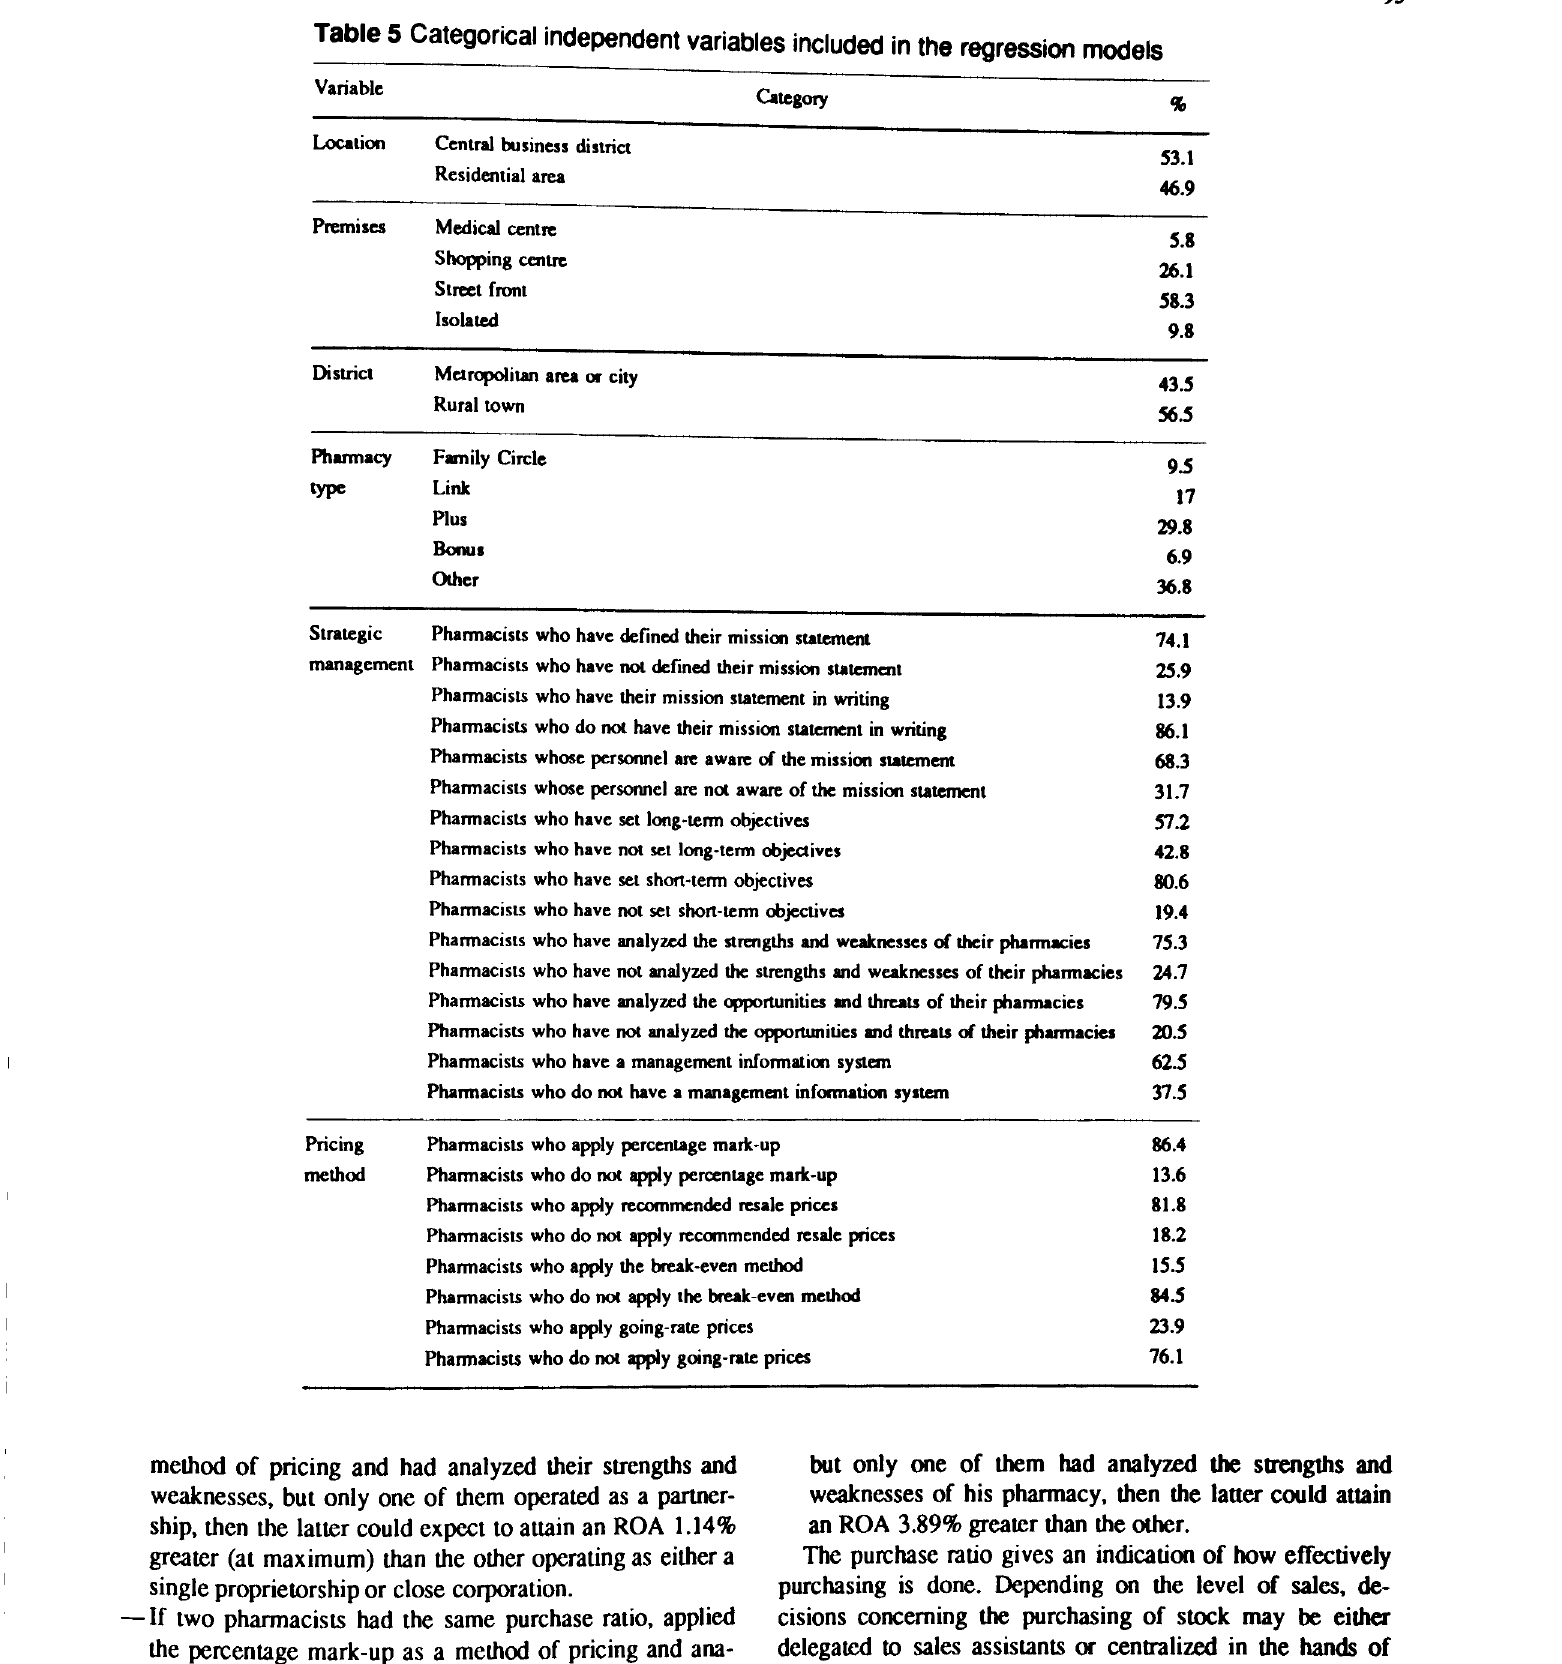
Table 5 Categorical independent variables included in the regression